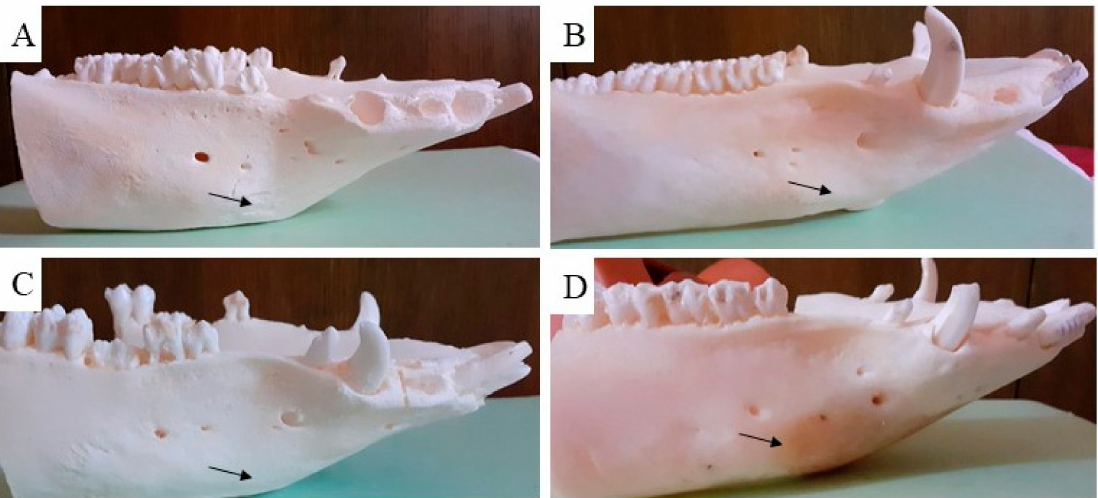
Figure 7. Macroscopic evaluation of the treated cortical bone defect after using the ceramic plate. The black arrow shows the place of the previous bone defect after treatment with the HAP ceramic plate in the time period ( A ) (3th), ( B ) (4th), ( C ) (5th) and ( D ) (6th month).